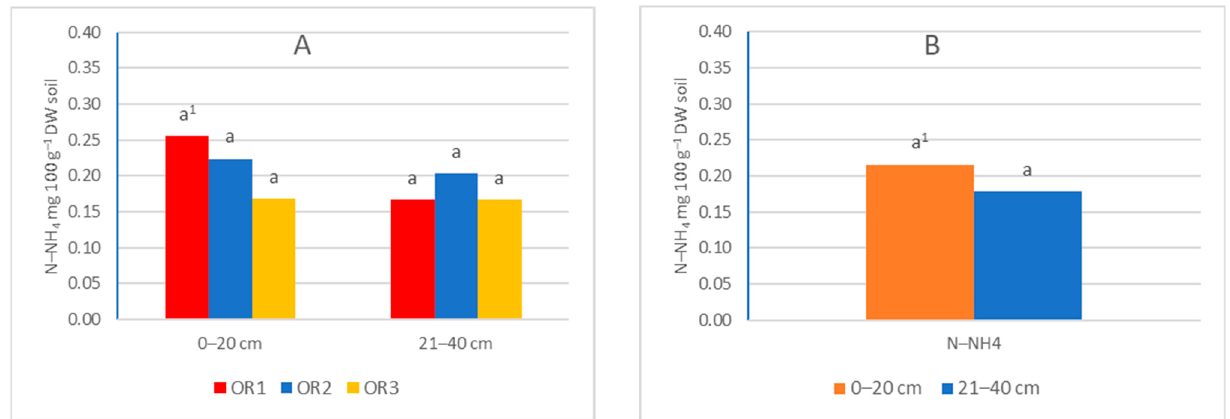
Figure 5. The content of N-NH 4 depending on the orchard ( A )—orchard × soil layer, ( B )—soil layer. 1 means that the same letters are not significantly different at α = 0.05 (Duncan’s test).